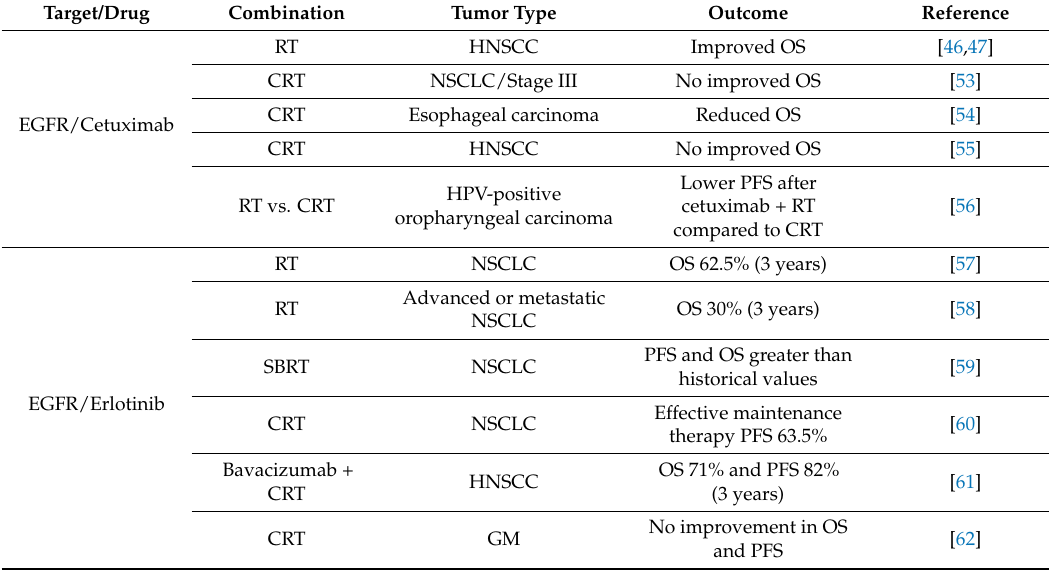
Table 1. Phase III clinical trials of EGFR monoclonal antibody cetuximab and early phase clinical trials of the EGFR tyrosine kinase inhibitor (TKI) erlotinib in combination with radiotherapy or